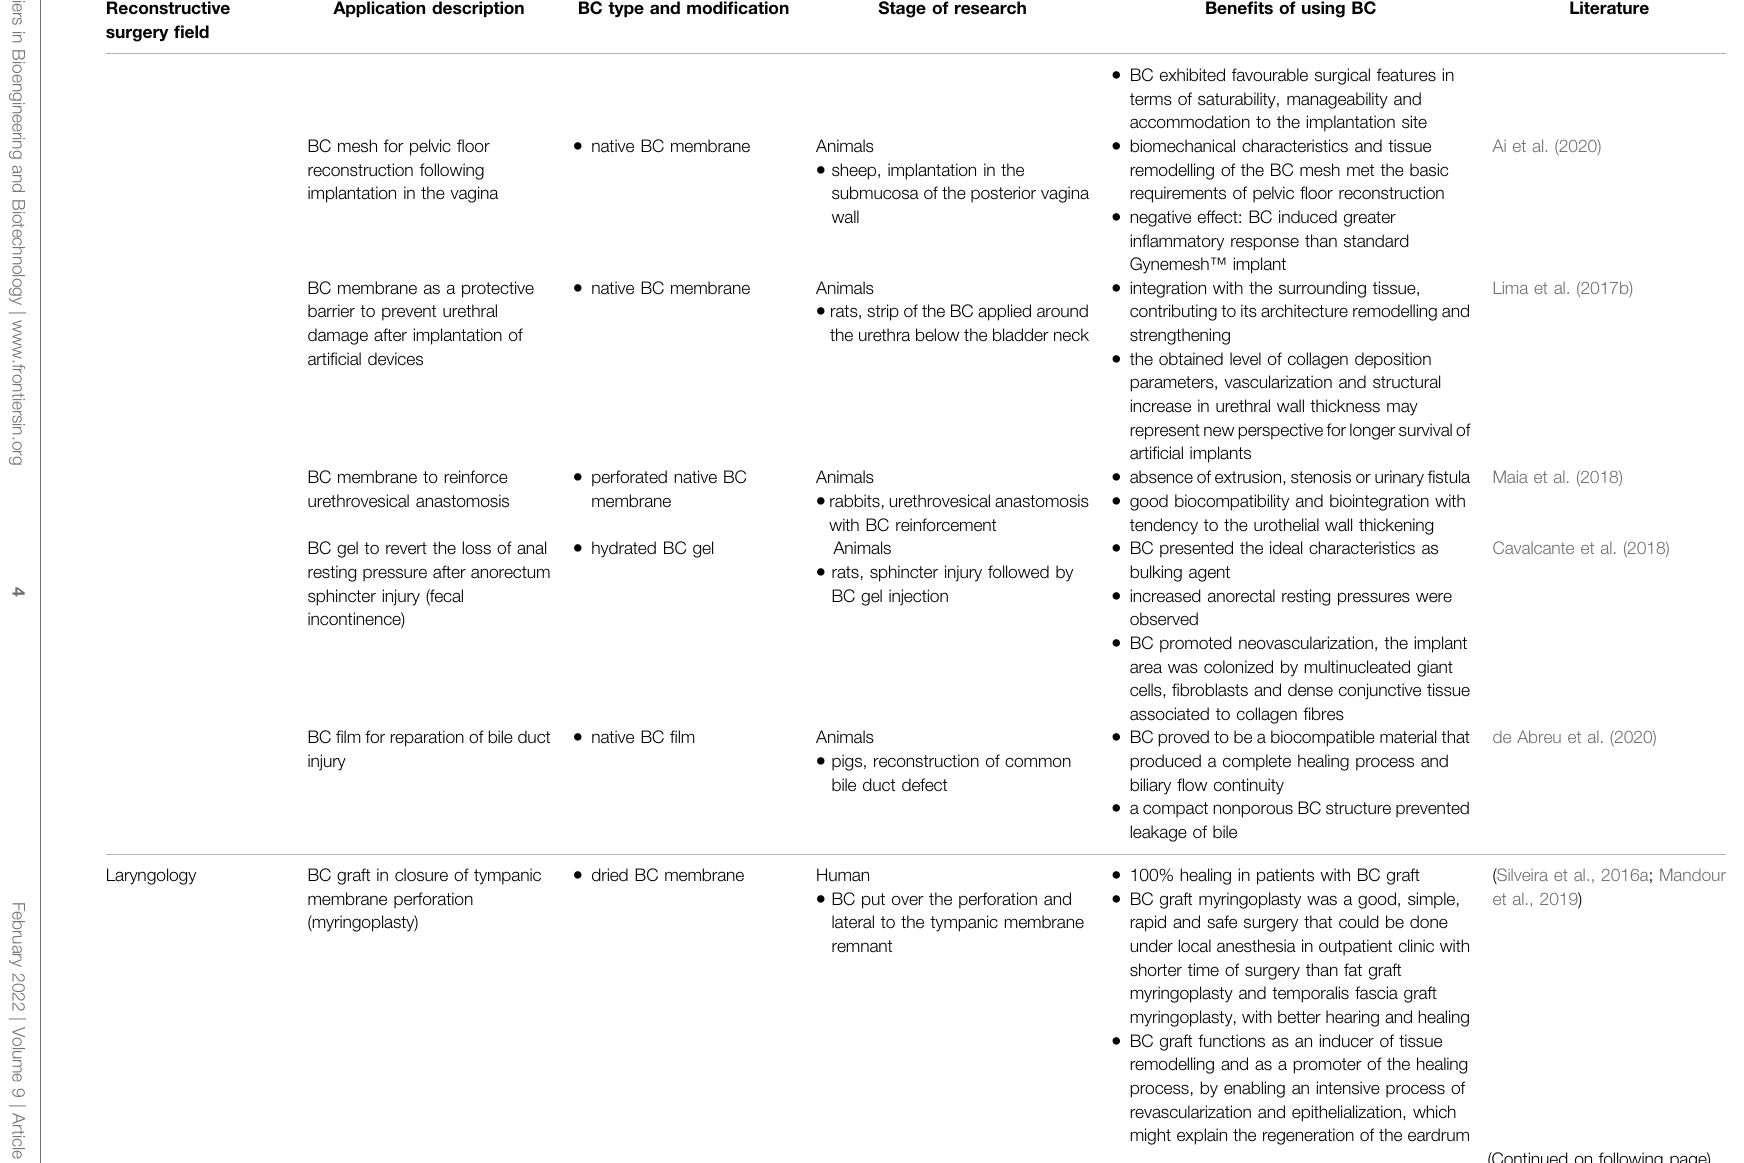
TABLE 2 | ( Continued ) Examples of applications of BC implants in reconstructive